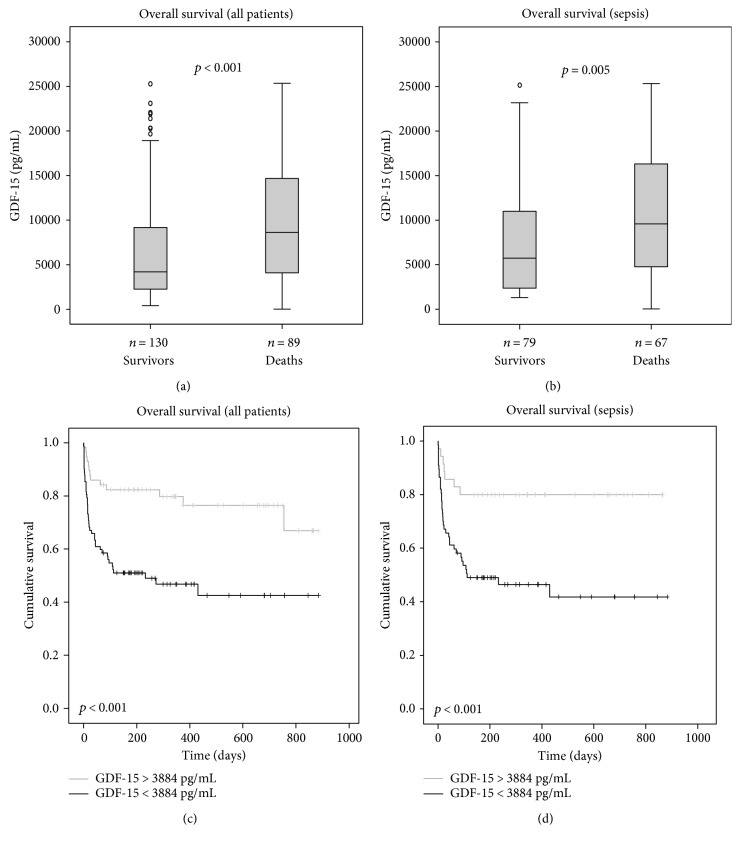
Prediction of overall mortality by GDF-15 serum concentrations. (a, b) Patients that died during the total observation period ((a) all patients; (b) sepsis only) had significantly higher serum GDF-15 levels on admittance to ICU than survivors (p < 0.001). (c, d) Kaplan-Meier survival curves of ICU patients are displayed, showing that patients with GDF-15 levels above a cut-off value of 3884 pg/mL have an increased overall mortality ((c) all patients; (d) sepsis only).